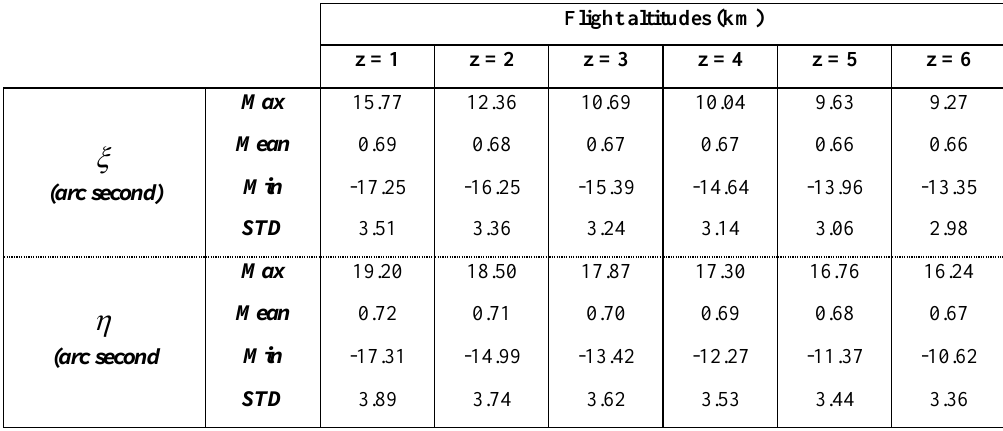
Table 1. Statistics of the DOV components (  ,  ) were obtained using the SWEN17 model at different flight altitudes in Sweden. Unit: arc second.